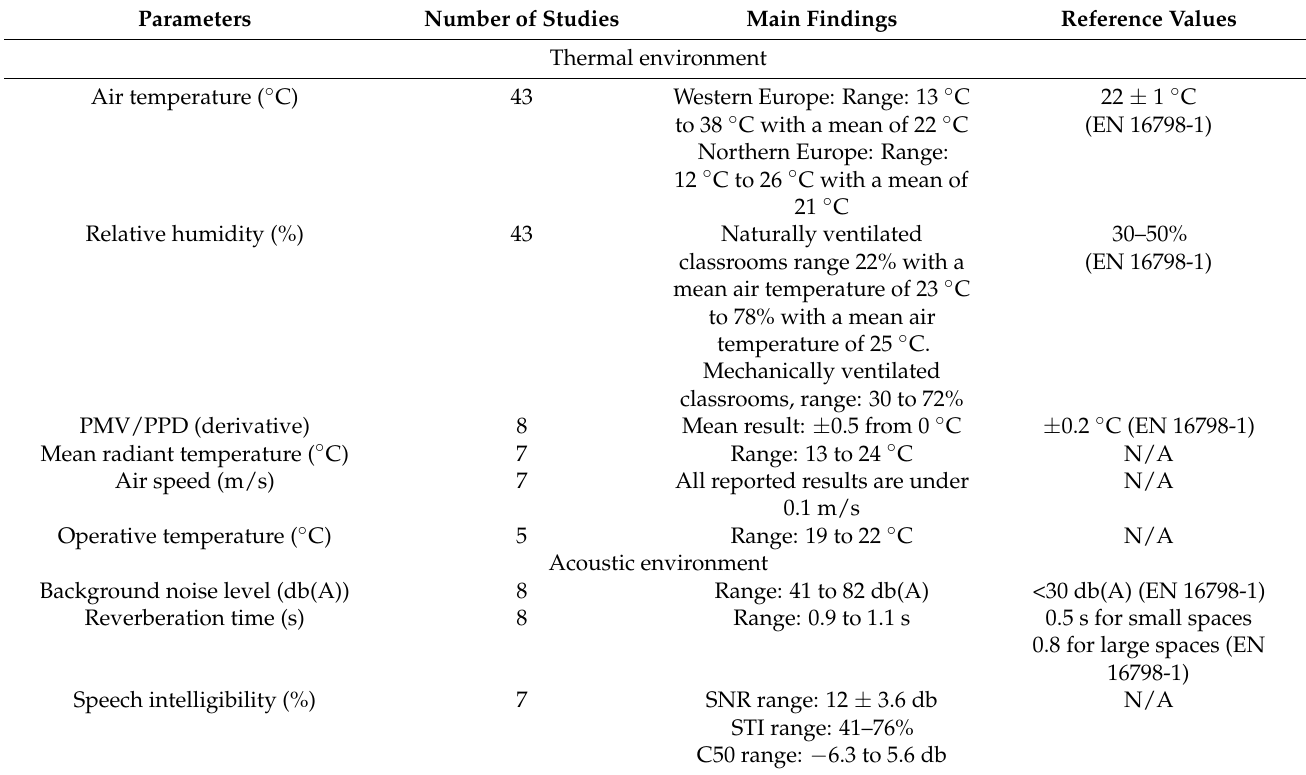
Table 2. Summary of the main results ( n = 88